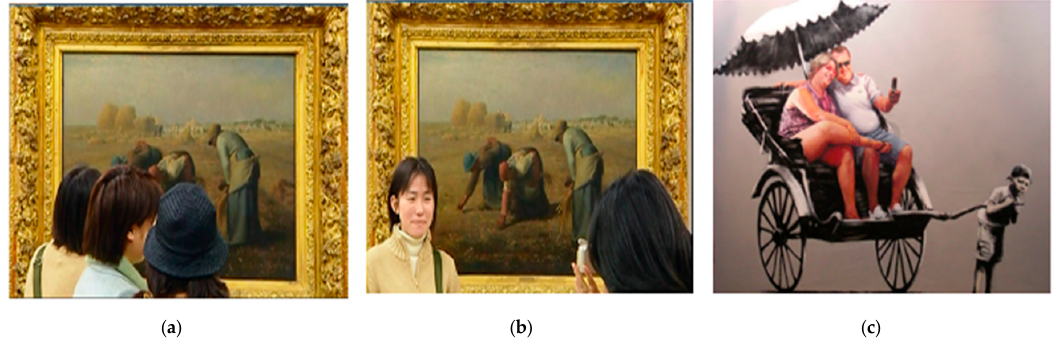
Figure 2. ( a , b ) Tourists in front of Millet’s Les Glaneuse in the Mus é e D’Orsay in Paris; ( c ) Banksy, Rickshaw